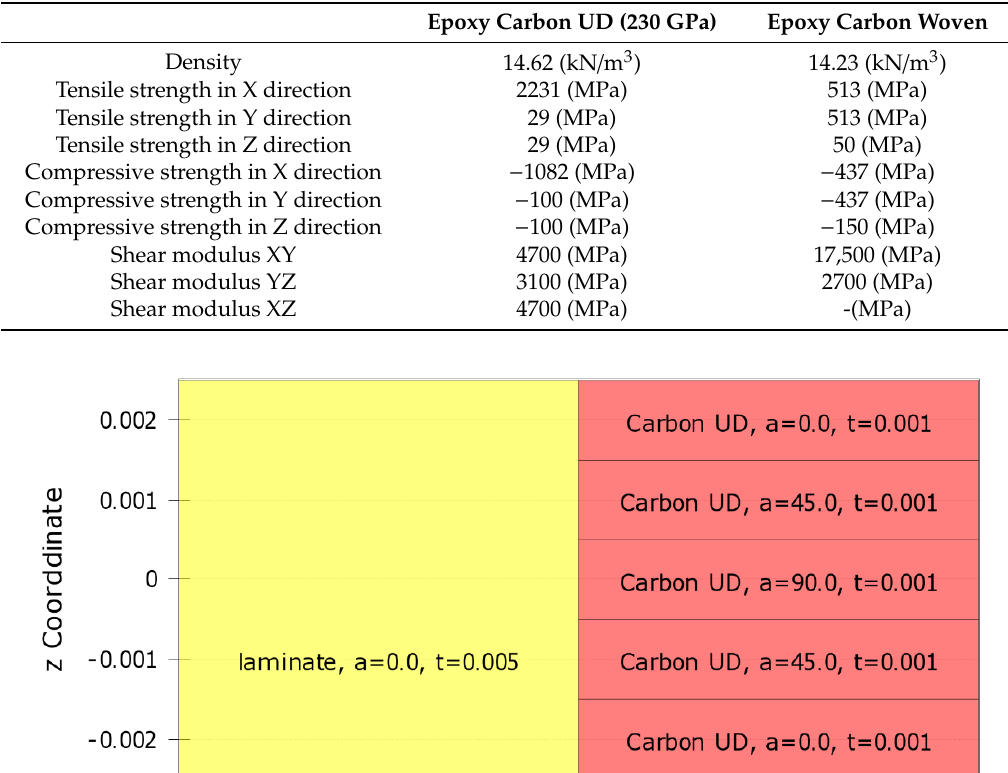
Figure 11. The laminate configuration for lower and side shells.